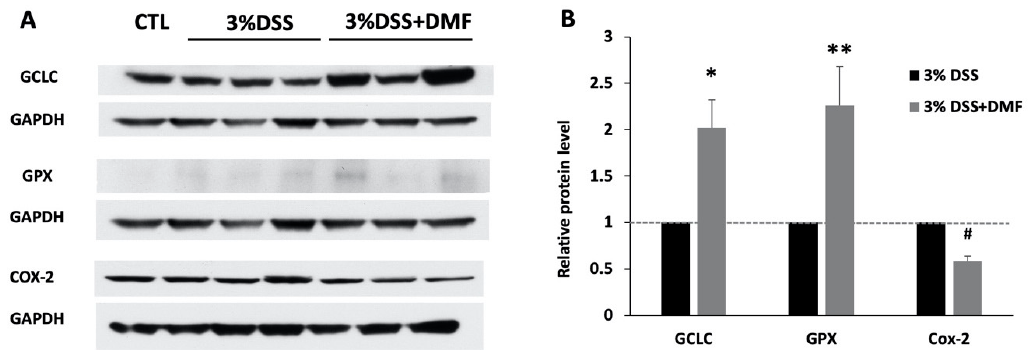
Figure 5. Western blot of colon tissues from mice given 3% dextran sulfate sodium (DSS) and 3% DSS + dimethyl fumarate (DMF) (25 mg/kg twice daily). ( A ) Representative western blots of glutamate ‐ cysteine ligase catalytic subunit (GCLC), glutathione peroxidase (GPX), and cyclooxygenase ‐ 2 (COX ‐ 2) from colon tissues of DSS ‐ induced colitis mice, with and without DMF treatment. ( B ) Relative protein level to control group. GCLC ( n = 5), GPX ( n = 5), COX ‐ 2 ( n = 6), data represent the mean ± SEM. * p = 0.028 or ** p = 0.04 or # p = 0.001 versus control group.